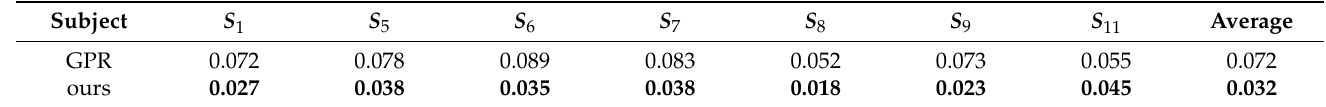
Table 2. Results of Bone proportion recovery (CPN 2D points). The spine is set as scale 1. GPR is the method proposed by [31] (Bold indicates higher accuracy).